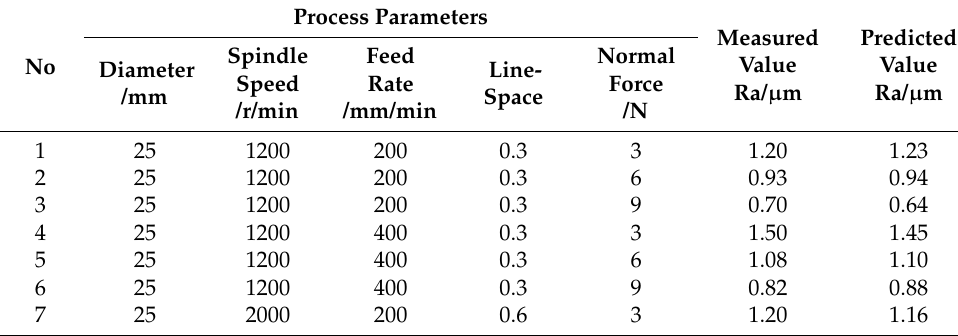
Table A2. The experiment results for